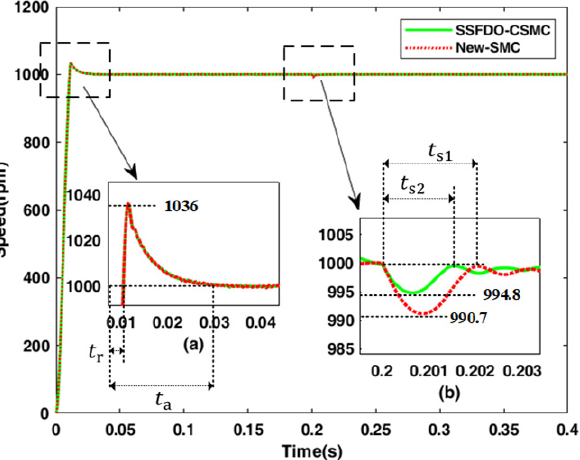
Figure 7. Speed response with or without observer: ( a ) starting performance, ( b ) disturbance rejection ability.